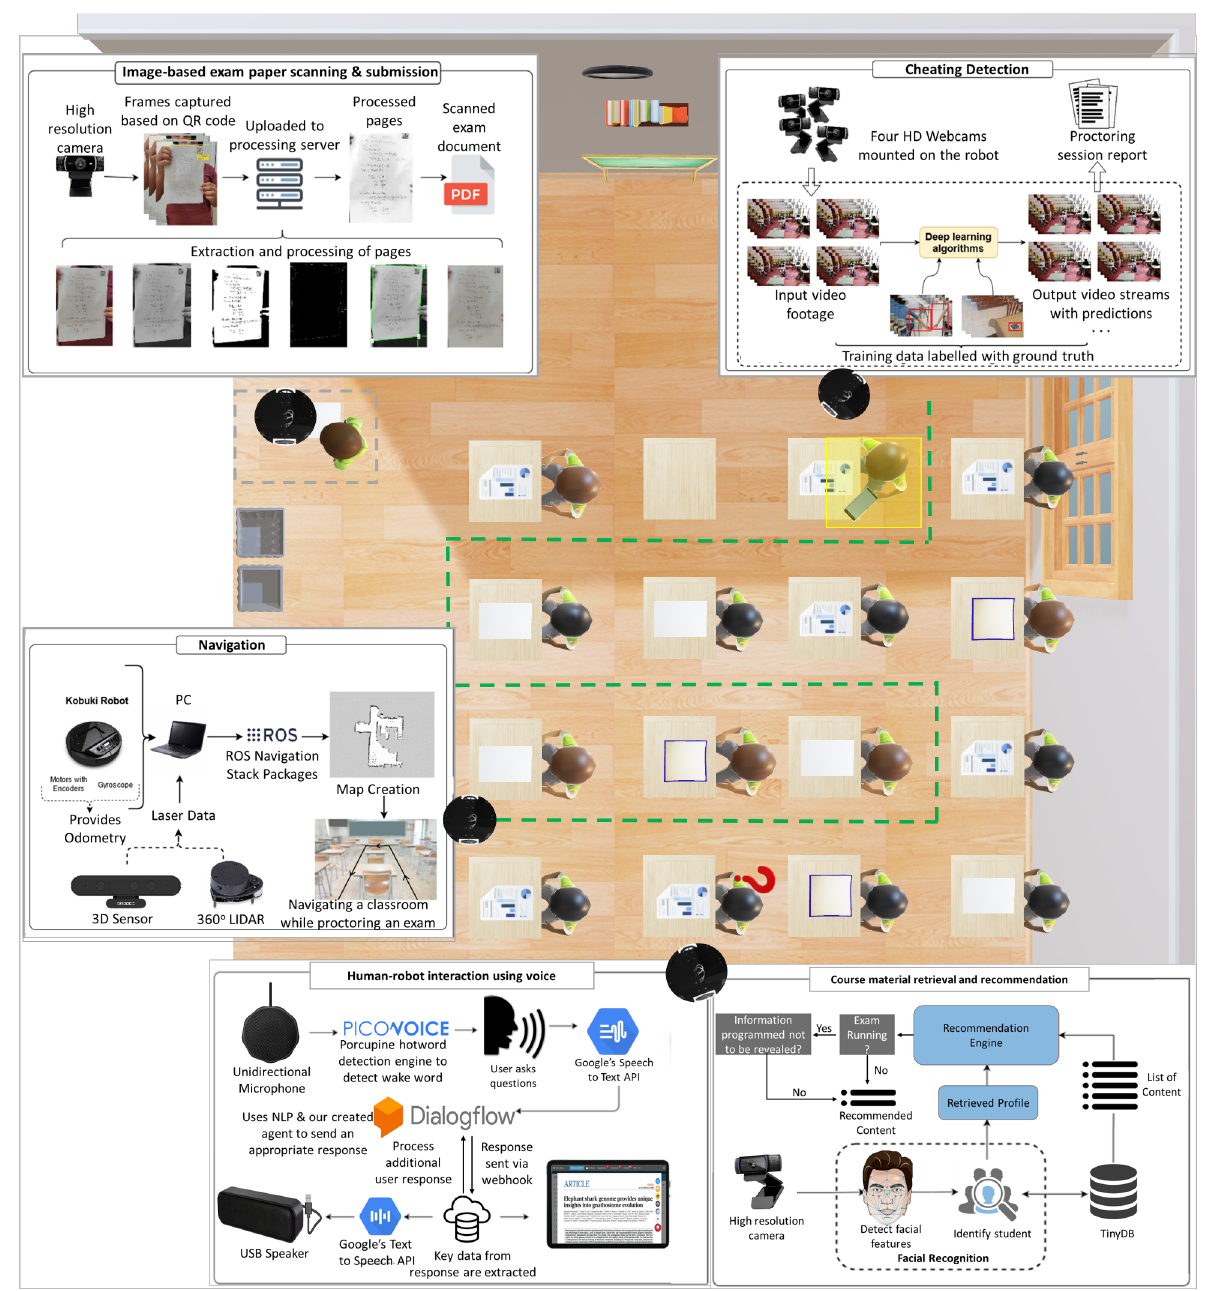
Figure 1. Overall system